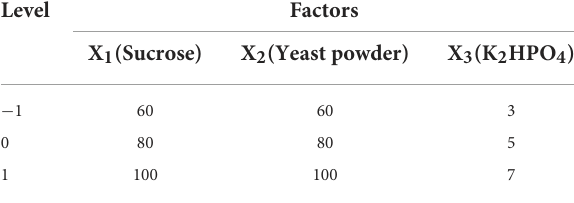
TABLE 1 Experimental design of RSM with 3 factors and 3